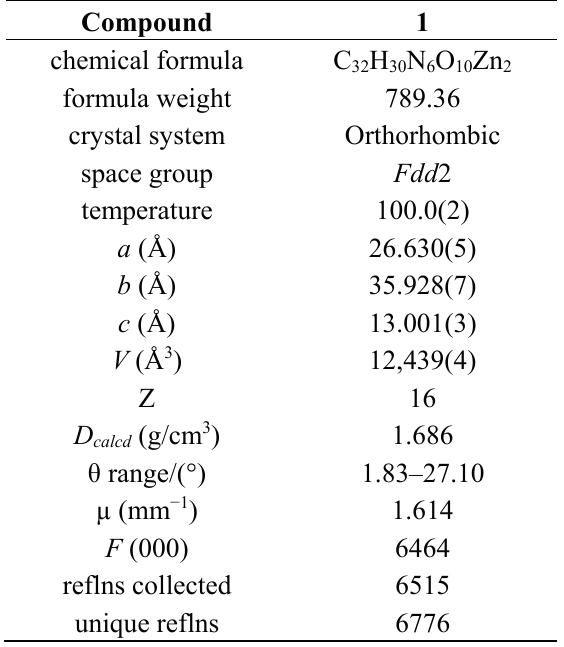
Figure 1. ( a ) The asymmetric unit of 1 ; ( b ) view of the local coordination environment of Zn1 center; ( c ) local coordination environment of Zn2 center [symmetry code: (i): ( − 0.25 + x, 0.25 − y, − 0.25 + z); (ii): (0.25 − x, 0.25 + y, 0.25 + z)]. Table 1. Summary of crystal data and refinement